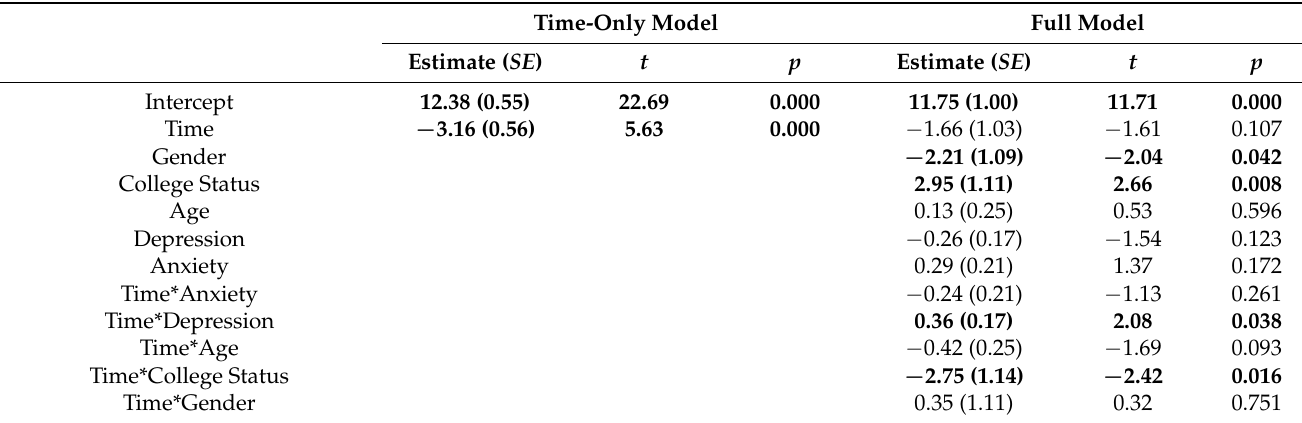
Table 2. Linear mixed models for drinking frequency